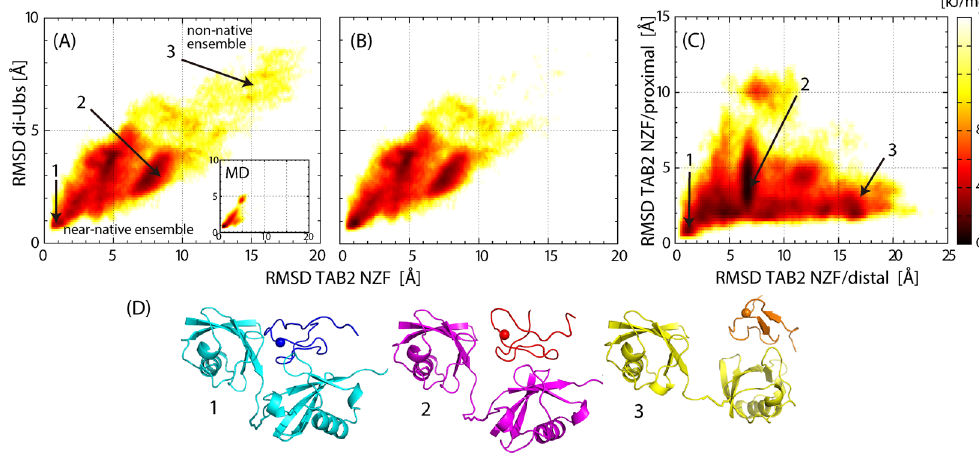
Figure 2. FES of K63 di-Ub/TAB2 NZF. ( A ) FES plotted on a two-dimensional space, C α RMSD values of TAB2 NZF, and di-Ub from the crystal structure (PDB: 2wwz) after superimposing C α atoms of the core regions of di-Ub (1–70). The inset is the same plot but calculated from five 150-ns MD simulations (Fig. S1A). The lower free energy region ( < 10 KJ/mol) is named as the “near-native” ensemble, while the higher free energy region ( > 10 KJ/mol) is named as the “non-native” ensemble. ( B ) The FES for the subset with the condition that TAB2 NZF contacts (any non-hydrogen atom pairs whose distance is less than 4 Å) both distal and proximal Ubs. ( C ) The same as ( A ) but plotted on the two C α RMSD values of TAB2 NZF, one superimposing the distal Ub (1–70) and the other superimposing the proximal Ub (1–70). ( D ) Three representative structures of the complex whose position in the FES are indicated by the numbers in ( A , C